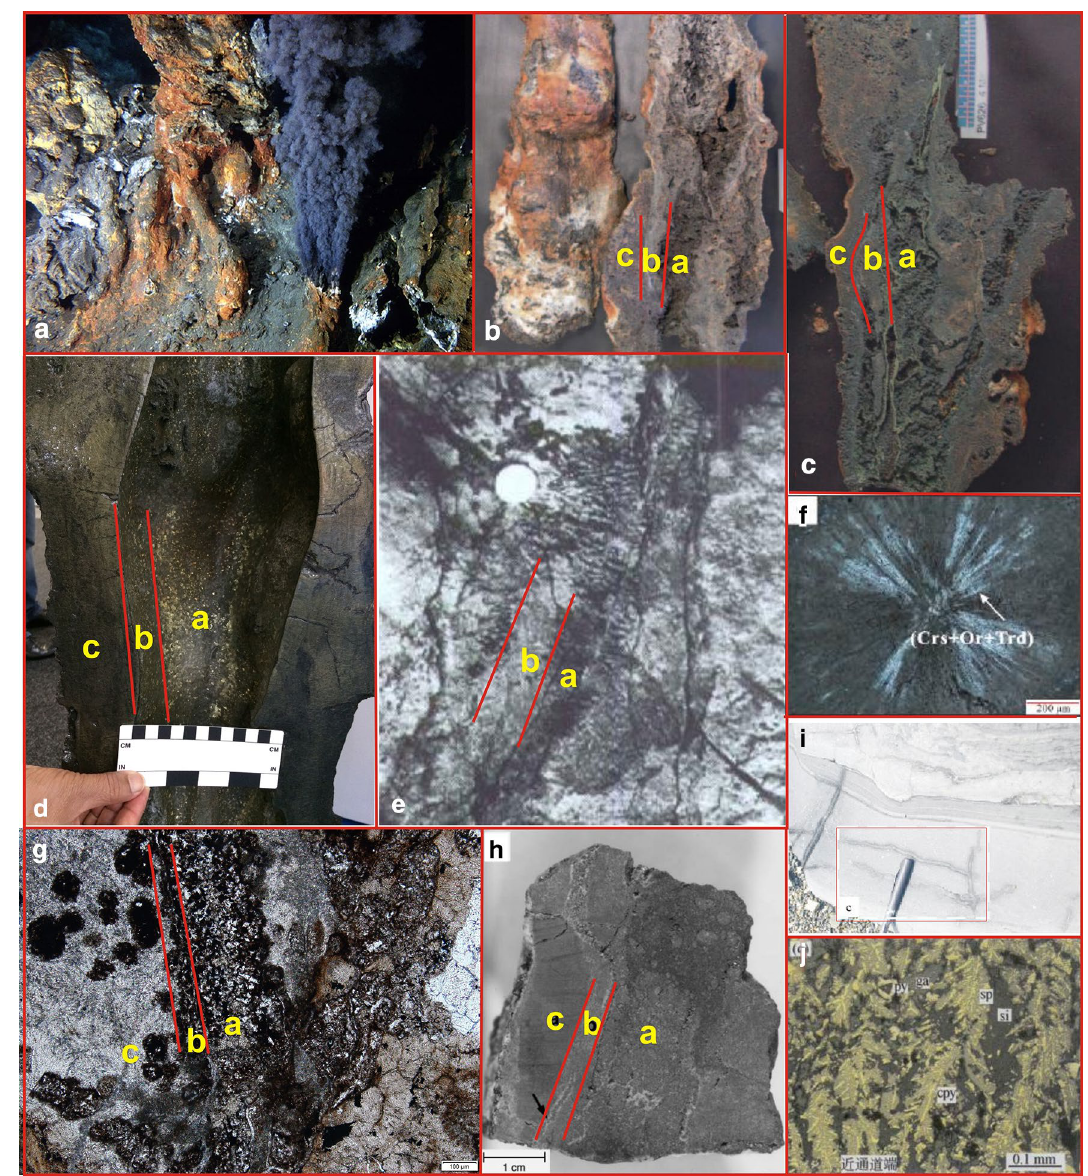
Figure 7. Comparison with previous research results. ( a ) Hydrothermal vent field near the Mid-Atlantic Ridge at 30° N 5 . ( b ) The outline of the black chimney of the Brothers submarine volcano 28 . ( c ) Black chimney section of the Brothers submarine volcano 28 . ( d ) The black chimney channel from the South African Geological Museum. Layer a in the figure is the outer wall of the channel, and layer b is the inner wall of the channel(Photo was taken by Liu Yiqun). ( e ) Photograph of hydrothermal sedimentary dolomite in a natural outcrop in the Sardinian mining area of Italy 22 , similar to the shape of the hydrothermal chimney in Fig. 3b. ( f ) The radial structure of the North Island hydrothermal zone, New Zealand 25 is similar to the radial structure of Fig. 3g. ( g ) Channel of the hydrothermal chimney in this study; layer a in the figure is the outer wall of the channel, and layer b is the inner wall of the channel. ( h ) TAG hydrothermal mound, Mid-Atlantic Ridge, 26° N 23 , similar to the channel structure of the study area in Fig. 3b. ( i ) Drainage structure. ( j ) Black chimney in North China 12